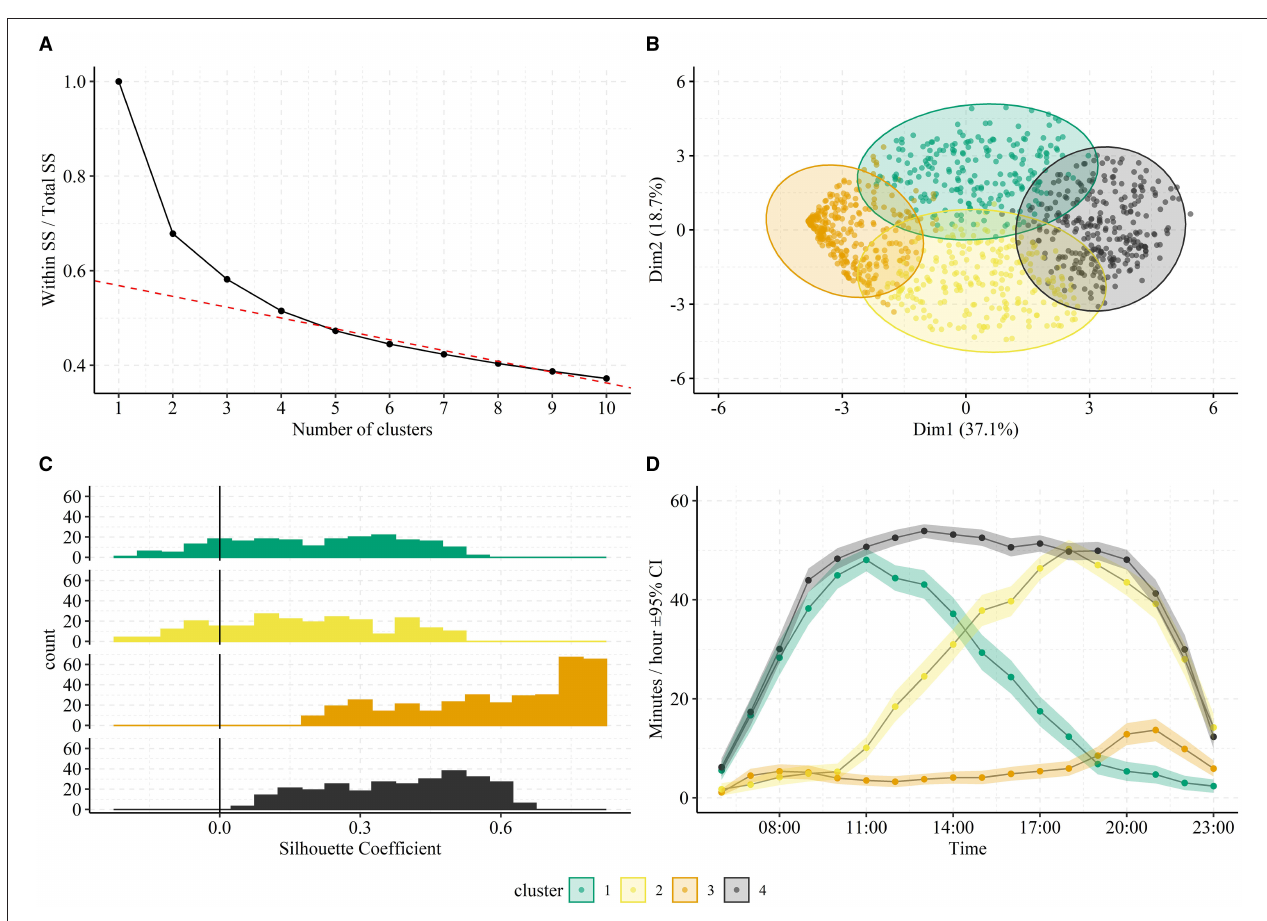
FIGURE 1 | Clustering of pooled hearing aid usage patterns. In (A) , the total within-cluster sum of squares (SS) normalized by the total SS is plotted against number of clusters. The “elbow” approach suggests selecting four clusters since adding additional clusters result in minor improvements. This is illustrated by the red dotted line, which represents the best linear fit to > 4 clusters. In (B) , the two most contributing dimensions of a principal component analysis of the usage patterns are plotted against each other with separation of the four identified clusters (colors). In (C) , the average time-course of usage patterns belonging to each cluster is shown. The shaded area in represents the 95% confidence intervals across usage patterns belonging to each cluster. The clusters one to four were associated with 19.1, 21.5, 33.5, and 25.9% of the participants days, respectively. In (D) , distributions of Silhouette Coefficients are shown for each cluster. The vertical line at 0.0 represents the threshold for poor clustering ( <